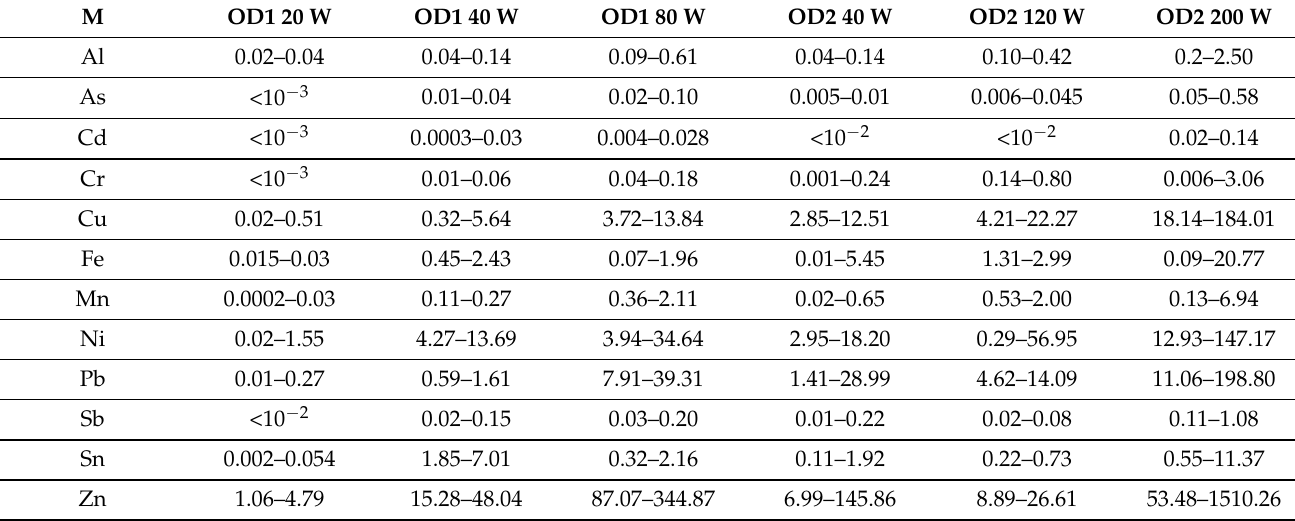
Table 5. Range of mass (in ng) per puff of each metal element for the sub-ohm tank devices OD1 and OD2 tested by Zhao et al. in their 2019 study [11] at three power levels (the numbers are rounded up to two decimals). These values were computed from the range of concentrations in µg/kg = ng/g reported in Table 2 of Zhao et al. and the information provided by Zhao et al. on aerosol collection (see Supplemental